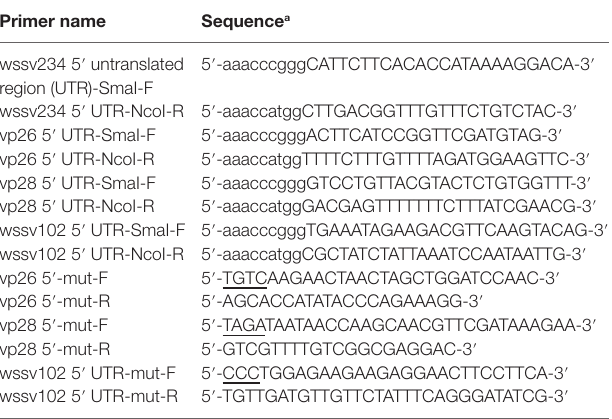
TaBle 1 | Primers used in the dual-luciferase assays in this